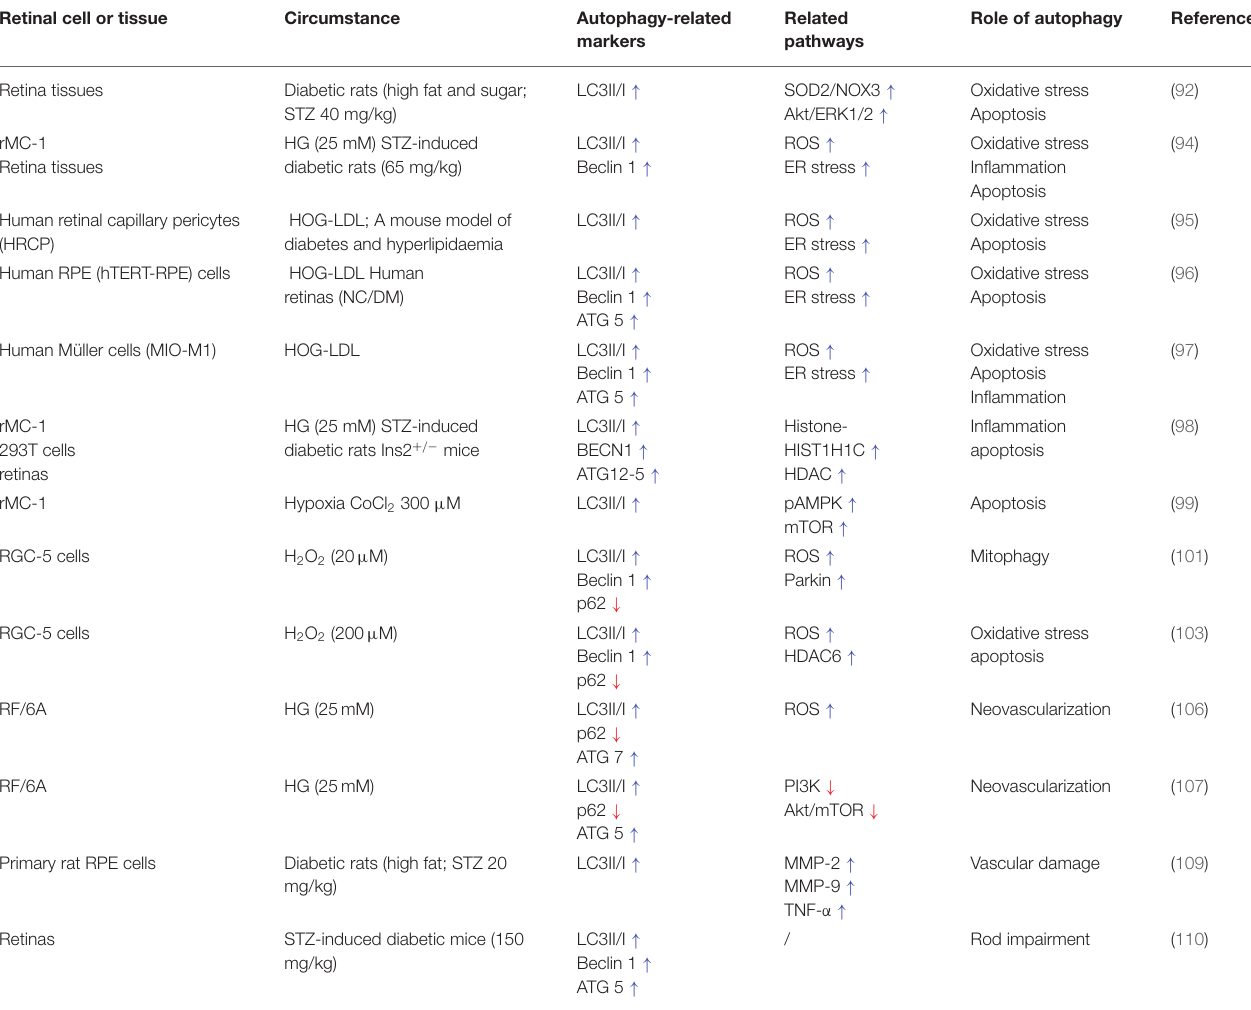
TABLE 2 | The detrimental effects of autophagy on